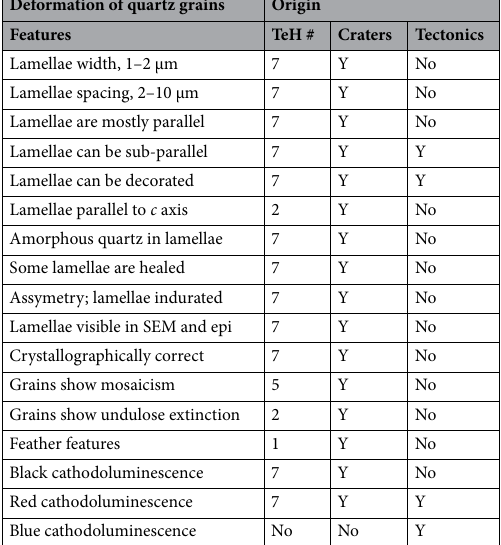
Table 2. Features of shocked quartz. Features found in shocked quartz from known impact craters (‘Craters’) compared to those from TeH and those found in tectonically deformed quartz grains (‘Tectonics’). ‘TeH #’ represents the number of observed TeH shocked grains. The TeH grains match 17 of 17 features for known impact-shocked material, whereas tectonically shocked grains match only 2 of 17 features, conclusively demonstrating that TeH grains are not